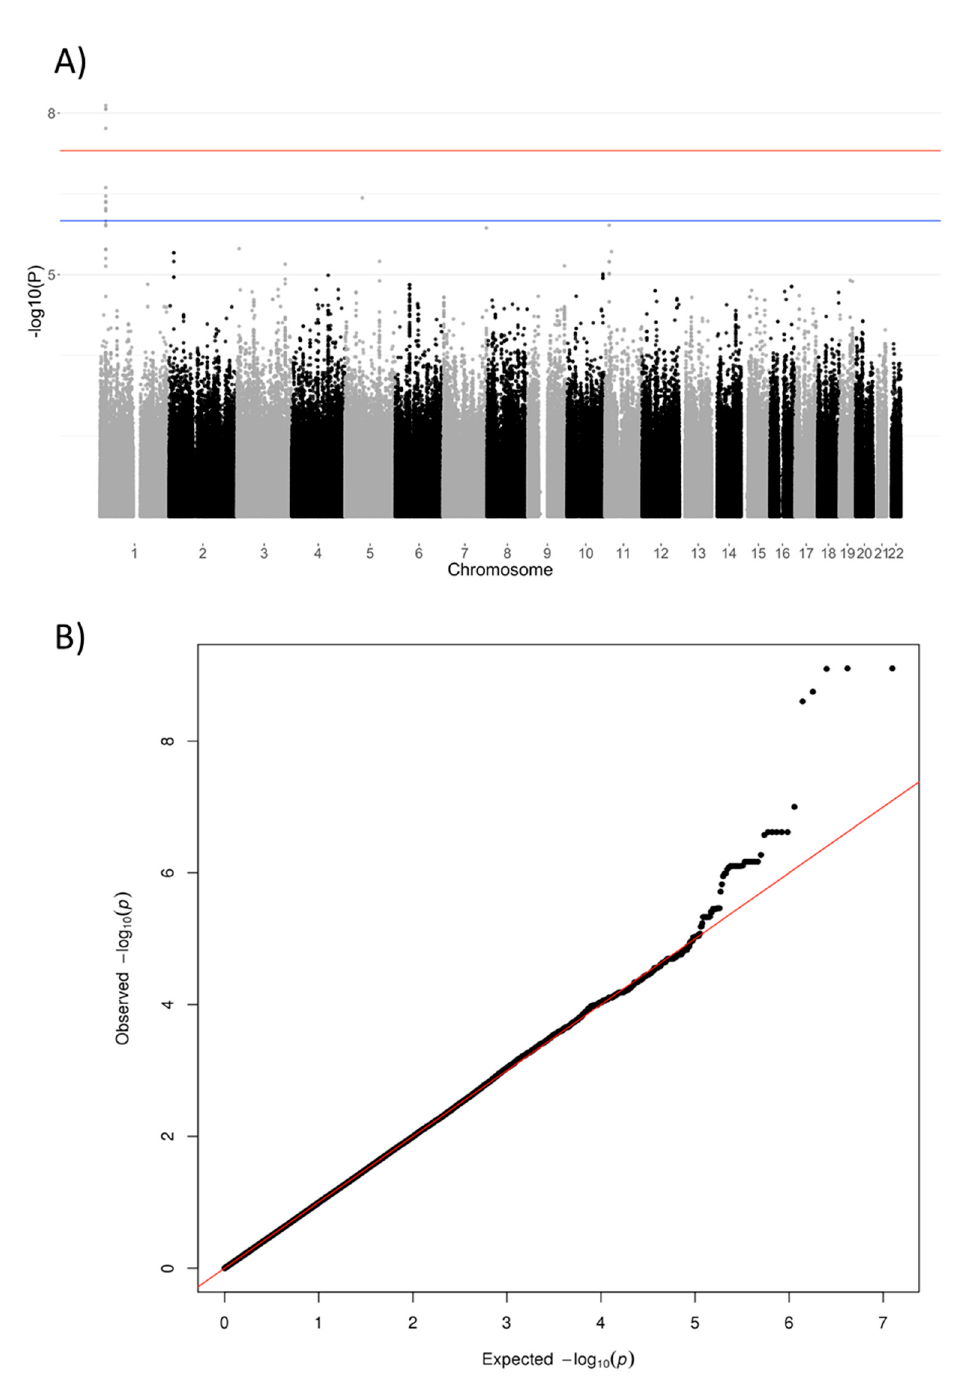
Figure 2. Manhattan plot of multivariate analysis of B6 metabolism in plasma and CSF ( A ). The red line indicates the genome-wide significance threshold of 5 × 10 − 8 , the blue line 1 × 10 − 6 . The QQ-plot of the association ( B ) indicating expected versus observed p -values. CSF: Cerebrospinal fluid; QQ-plot: Quantile-quantile-plot.